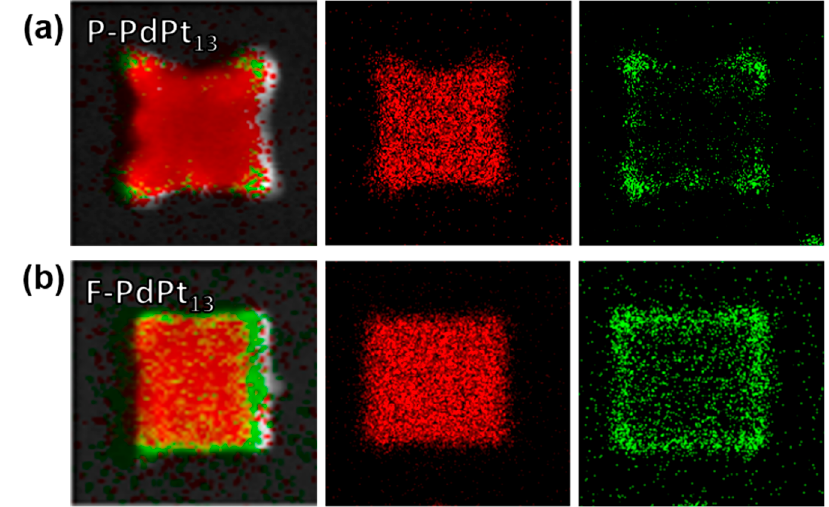
Figure 2. EDX mapping images of ( a ) P-PdPt 13 and ( b ) F-PdPt 13 . Red and green areas correspond to Pd and Pt, respectively.